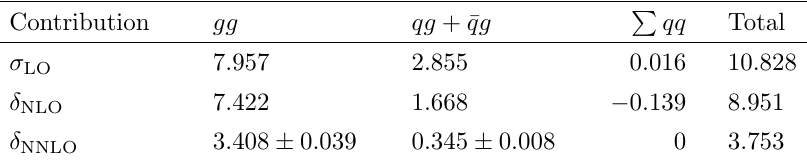
Table 4 . Cross-sections in picobarns, broken down by channel, using the BCMPS cuts, from the code used in ref.